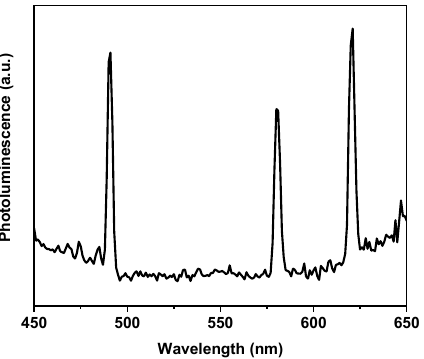
Figure 3. Photoluminescence spectrum of the prepared Bi 2 Fe 4 O 9 /GA composite.